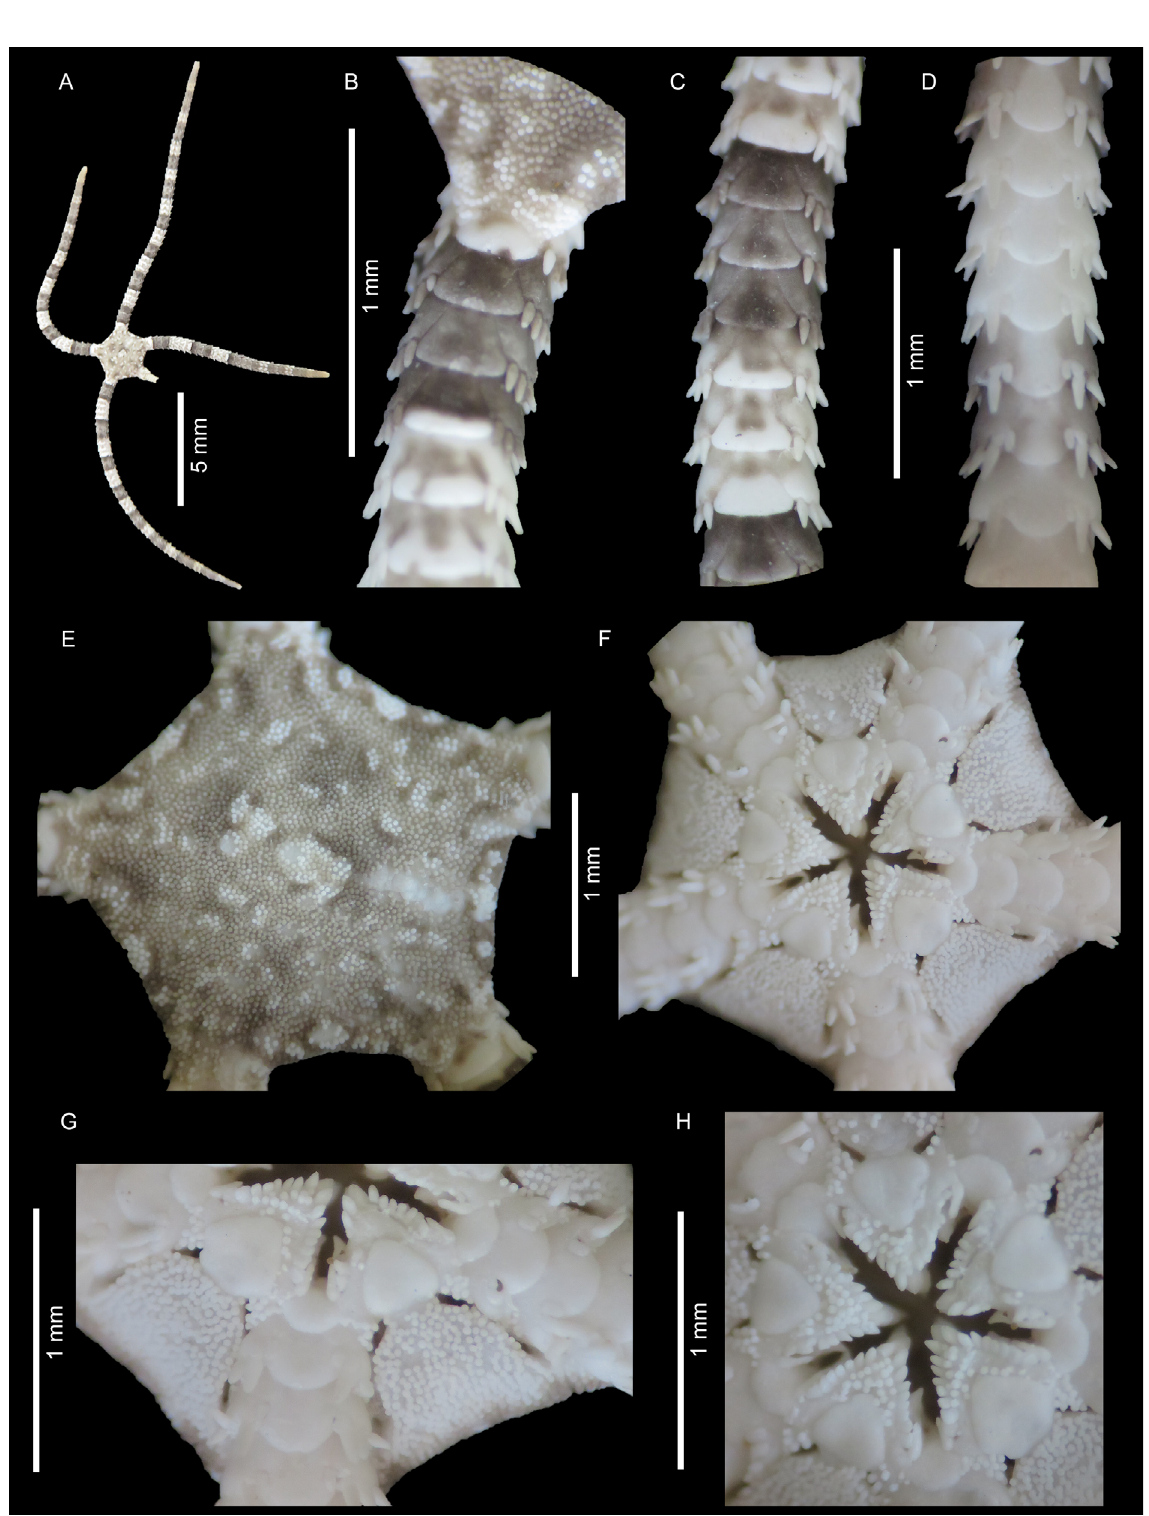
Fig. 4. Ophioderma hendleri sp. nov., paratype (ICML-UNAM 18319, DD = 2.2 mm). A . Dorsal view. B . Basal dorsal arm. C . Dorsal arm. D . Ventral arm. E . Dorsal disc. F . Ventral disc. G . Interradii. H .